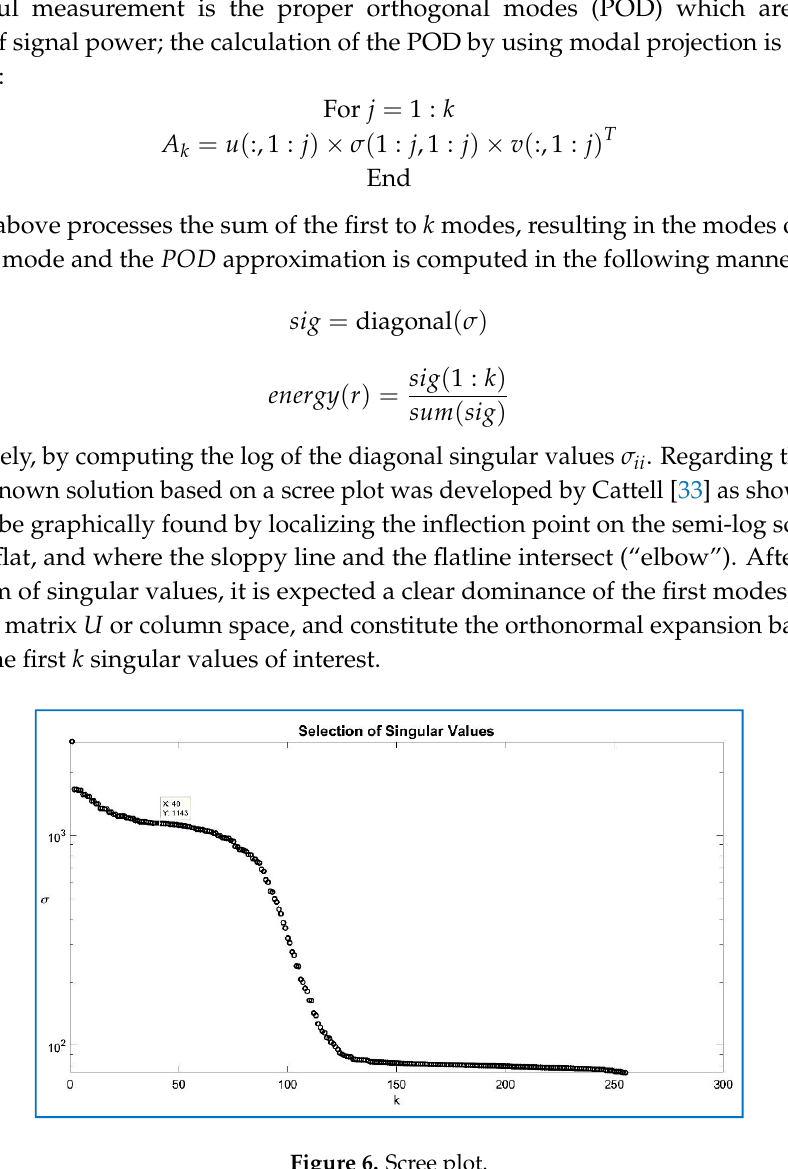
Figure 6. Scree plot.